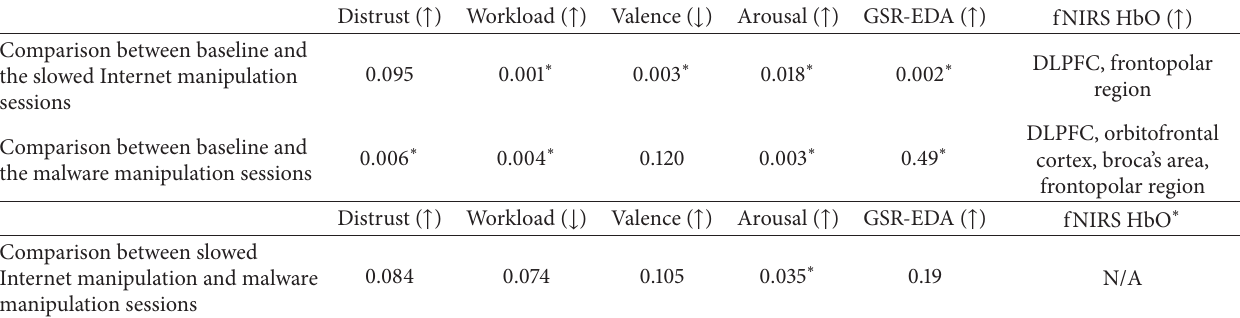
Table 1: 𝑃 values for 𝑡 -tests comparing the effects of the manipulations on the dependent